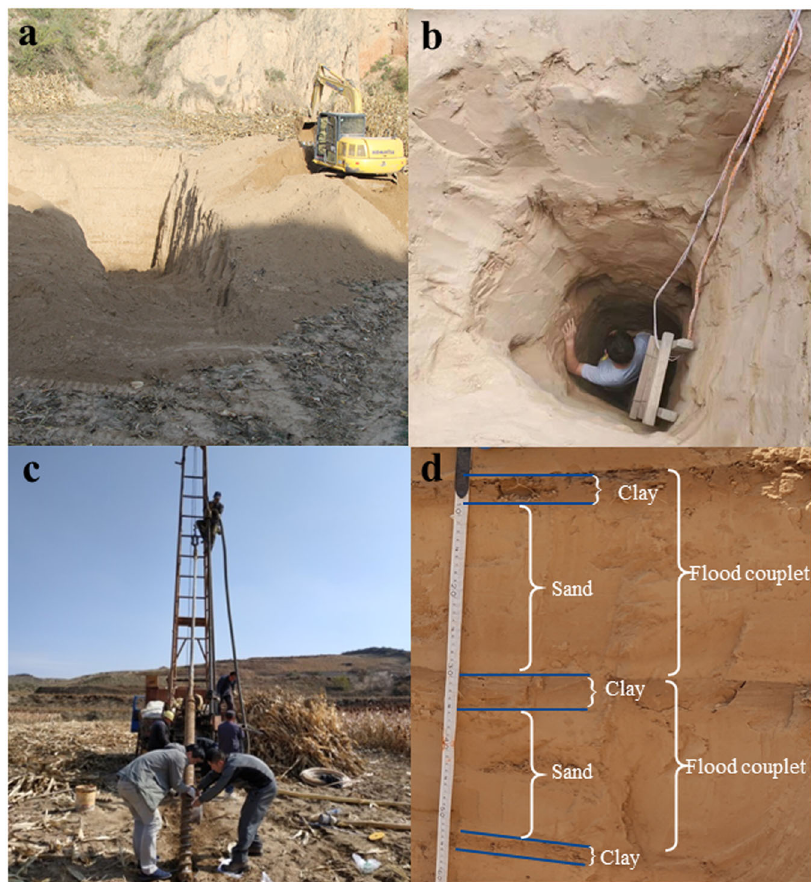
Fig. 4 Different sediment sampling methods. a – c Excavator, manual well digging, and well-drilling machine. d Flood couplets with clay and sand layer.